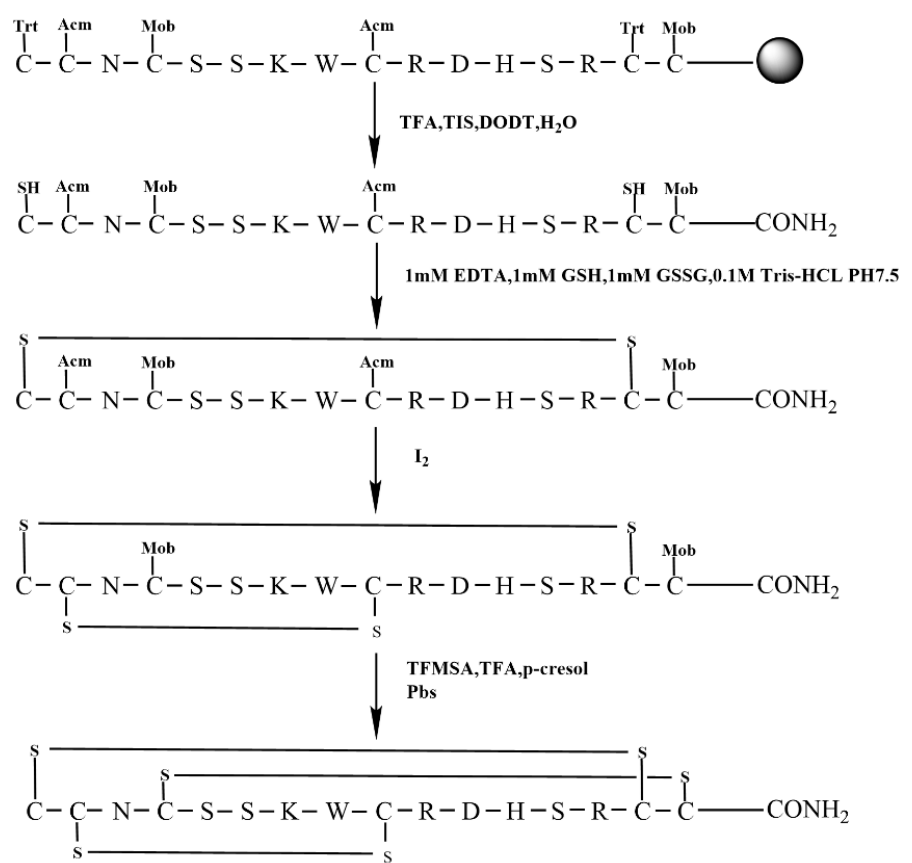
Figure 6. The scheme of regioselective oxidative folding of KIIIA with Trt/Acm/Mob orthogonal Cys protection (Scheme 3 ).